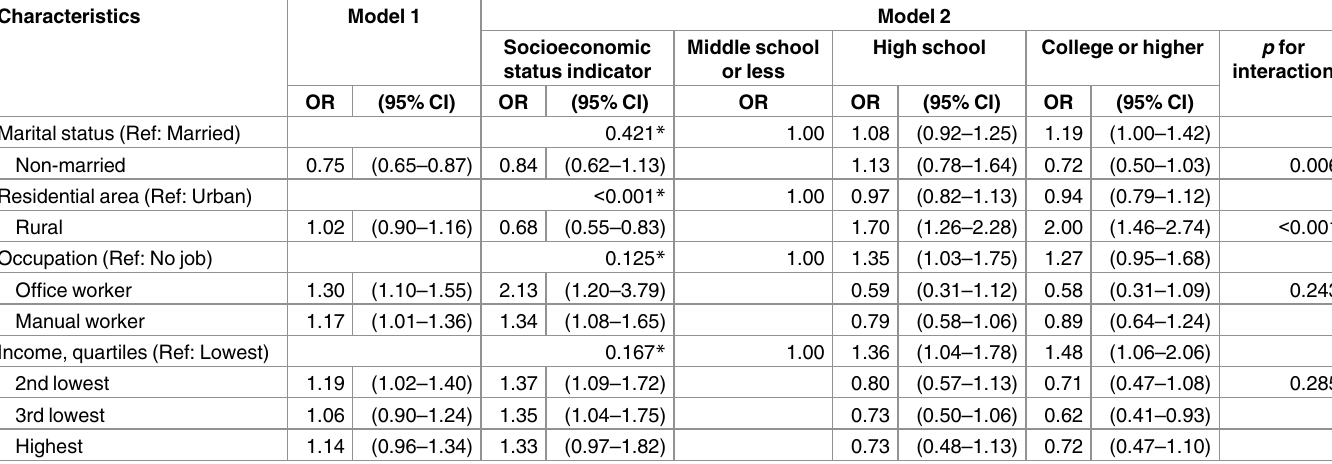
Table 6. Adjusted results of the main and interaction effectsof each socioeconomic status indicator and education on obesity in men.